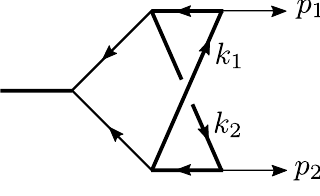
Figure 2 . Triangle with massive